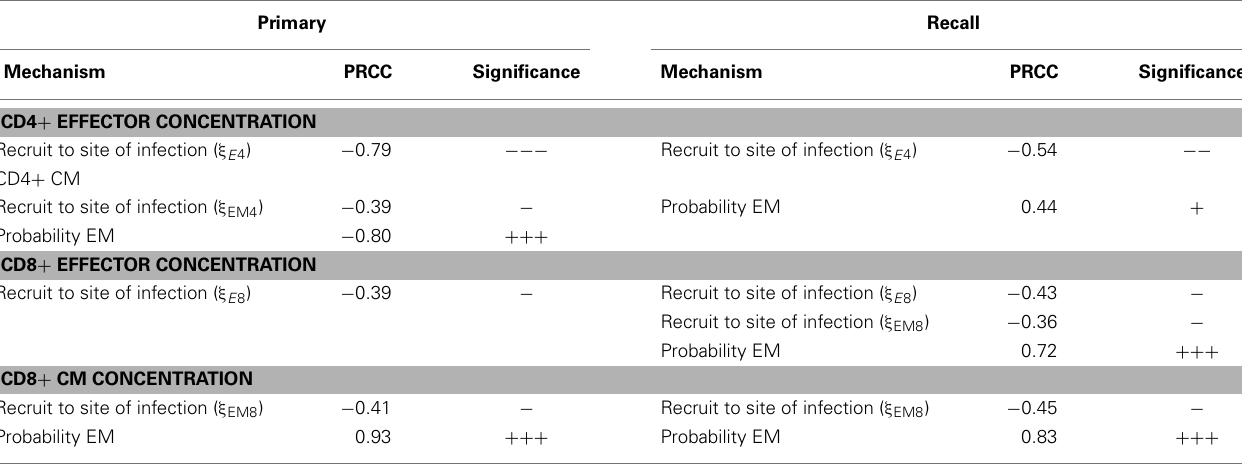
Table 3 | PRCC results: tracking sensitivity of concentrations of cells in blood to blood